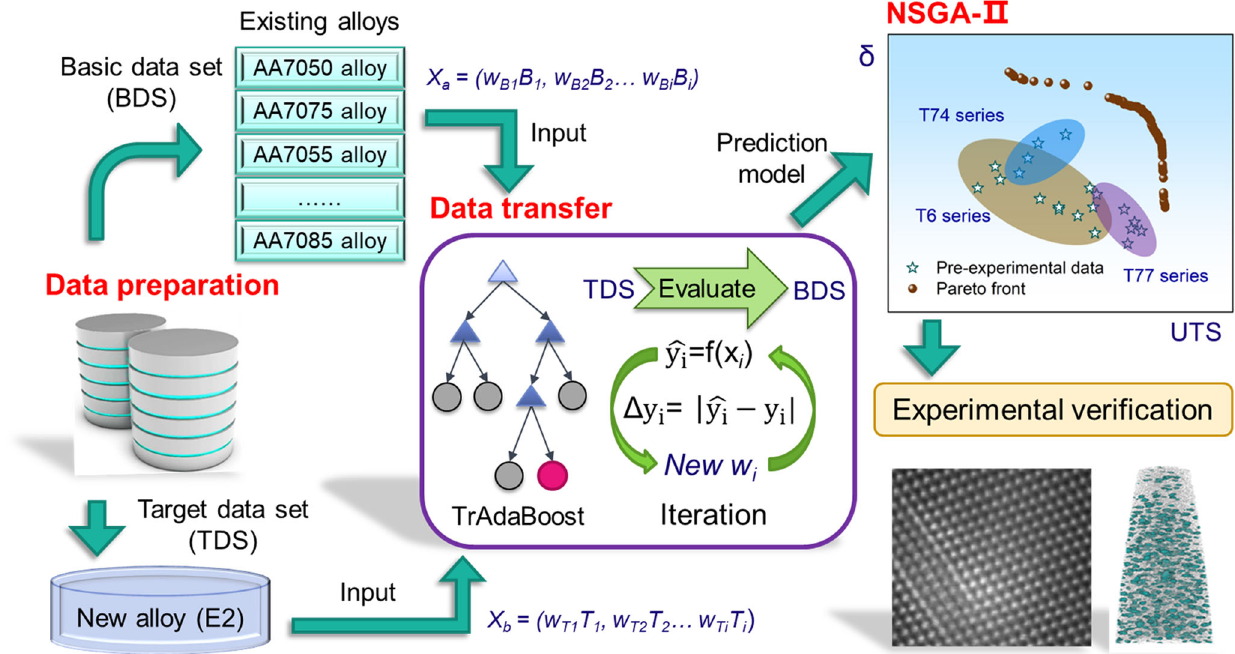
Fig. 1 A strategy of designing the solution-aging process for a new aluminum alloy. A strategy of designing the solution-aging process for a new aluminum alloy combining TrAdaBoost data transfer learning algorithm and multi-objective genetic algorithm